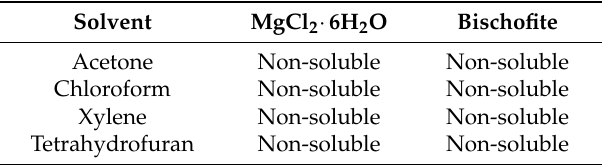
Table 3. PCM-solvent